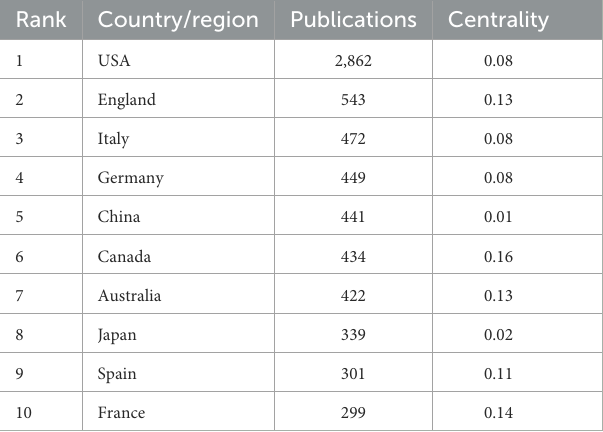
FIGURE4 Map of institutions on LChD from 2002 to 2021.